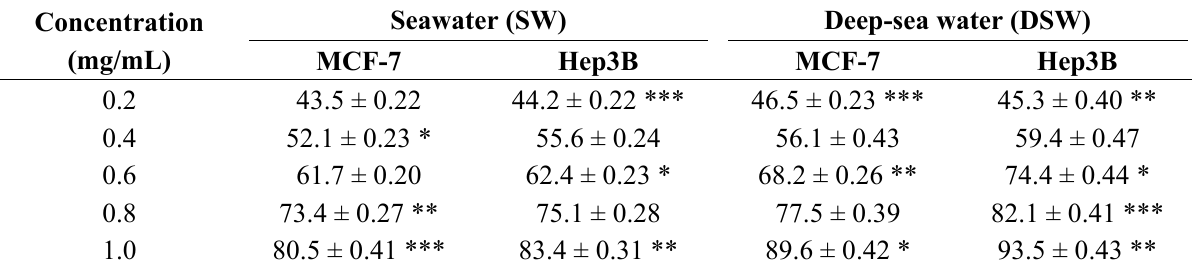
Table 1. Inhibition of cell growth of MCF-7 and Hep3B cancer cell lines after addition of the extract under various cultivation